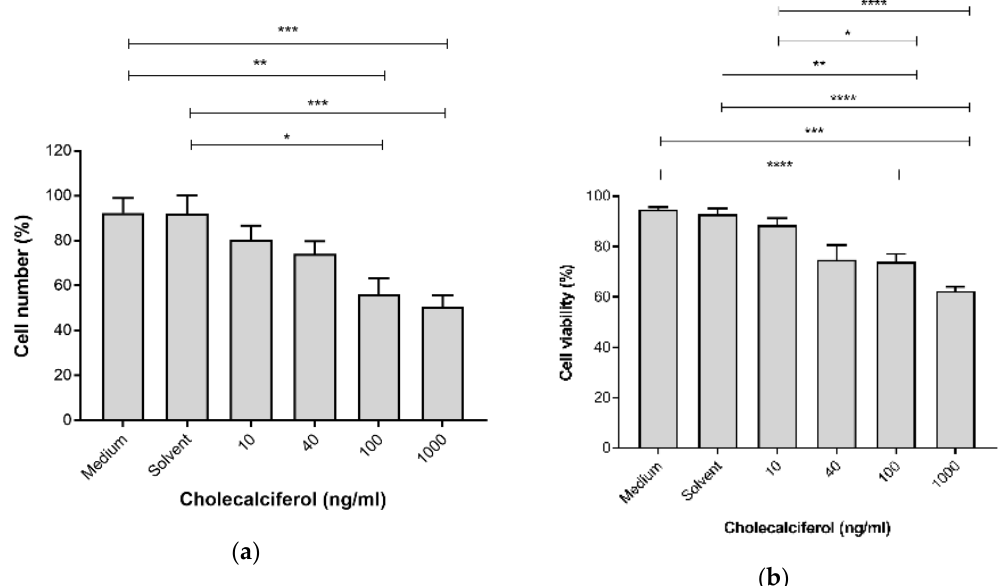
Figure 1. Cell count ( a ) and cell viability ( b ) in the control and experimental CaSki cultures. Cholecalciferol caused statistical inhibition at 100 and 1000 ng / mL treatments in comparison to the low-dose treatment (10 ng / mL) and control cultures. Experiments were performed in triplicate on three biological repeats. Values are expressed as mean ± SEM ( p < 0.05 was considered statistically significant). * p < 0.05; ** p < 0.01; *** p < 0.001; **** p <